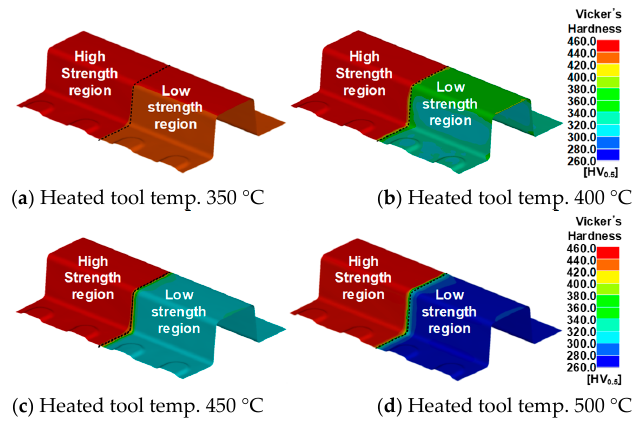
Figure 6. Predicted hardness distribution of partially quenched part for various heated tool temperatures at quenching time of 10 s.